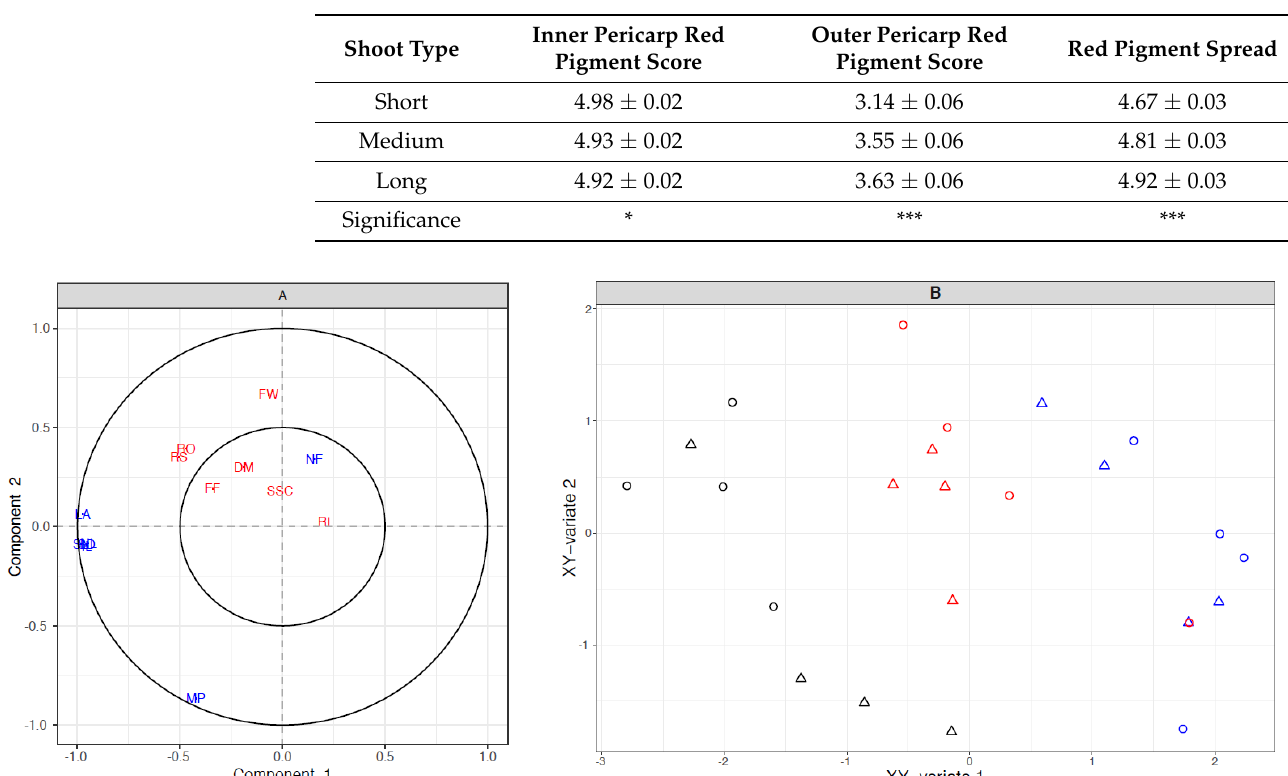
Figure 8. Correlation based relationships between shoot variables (X, with data collected in November) and fruit variables (Y, with data collected at harvest) for Actinidia chinensis var. chinensis ‘Zes008’ vines. ( A ) Correlation circle plots of X (blue—shoot) variables (SD, shoot diameter, SL, shoot length, NF, number of fruit, NL, number of leaves, IL, internode length, LA, leaf area, MP, mean photosynthesis) with Y (red—fruit) variables (FW, fresh weight, DM, dry matter, FF, firmness, SSC, soluble solids content, RS, red pigment spread, RI, inner pericarp red pigment, RO, outer pericarp red pigment). Cluster of blue—shoot variables at position ( − 1.0, − 0.1) includes: SD, SL, NL and IL. ( B ) sPLS xy-bivariate plot using shoot and fruit variables. Symbol colour represents shoot type (blue—short shoots, red—medium shoots, black—long shoots) while represent shoots from vines with ‘Bruno’ rootstocks and (cid:52) represents shoots from vines on A. macrosperma (cid:35)